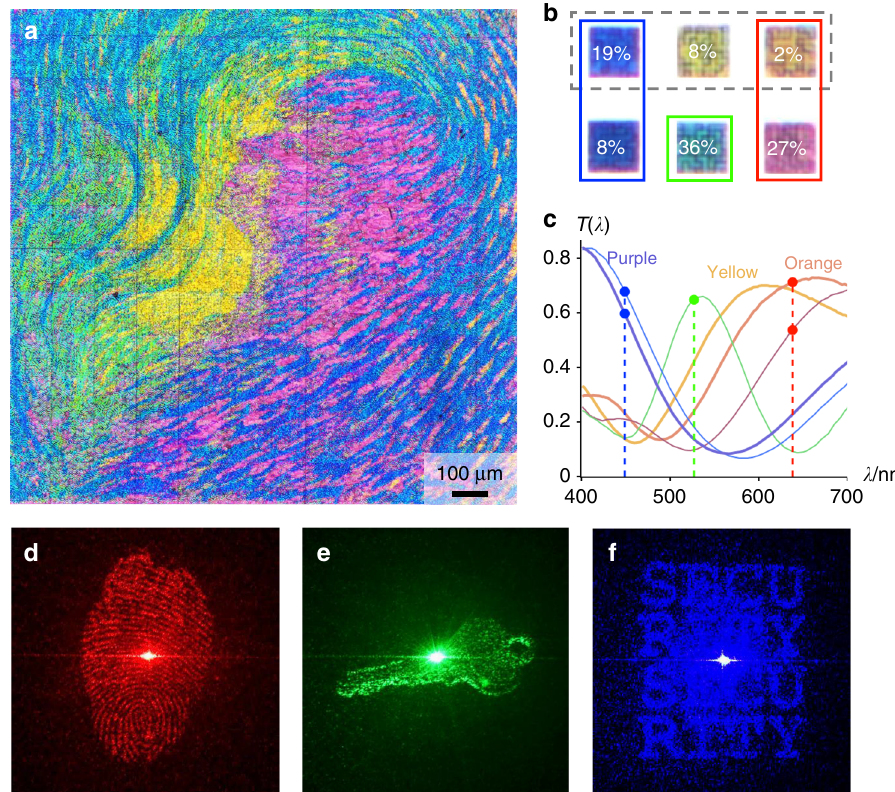
Fig. 4 Enhanced optical security provided by a six-colour holographic colour print. a Transmission optical micrograph of the colour print, a 480 × 480 pixel (1.44 mm square) reproduction of Luigi Russolo ’ s painting Perfume under which three holograms have been multiplexed. The ability to include colours that are less suitable for multiplexing the holograms (spectral freedom) allowed us to expand the usable colour palette to a total of six colours. b Optical micrographs of pillar arrays that produce the colours used in the print: added colours orange, yellow, purple (micrographs marked with a dashed box) and original colours red, green, and blue. Overlaid percentages on the micrographs of each pillar array denote the proportion of pixels in the print with that colour. Coloured boxes around the pillar micrographs indicate that they are used in the hologram channel of that colour. c Transmission spectra of pillar array colour fi lters used in the print: original colours in thin lines; added colours in thick lines. d – f Holographic projections of the print in transmission, photographed on a white wall in a darkened room: d a red thumbprint, e a green key, and f blue lettering that reads “ SECURITY ” . Illumination sources were 638 nm red, 527 nm green, and 449 nm blue lasers, respectively. The projection size scales with the projection distance, reaching an average size of ~10 cm at a distance of 1 m. Original source images and simulation results of the colour image and holograms can be found in Supplementary Fig.